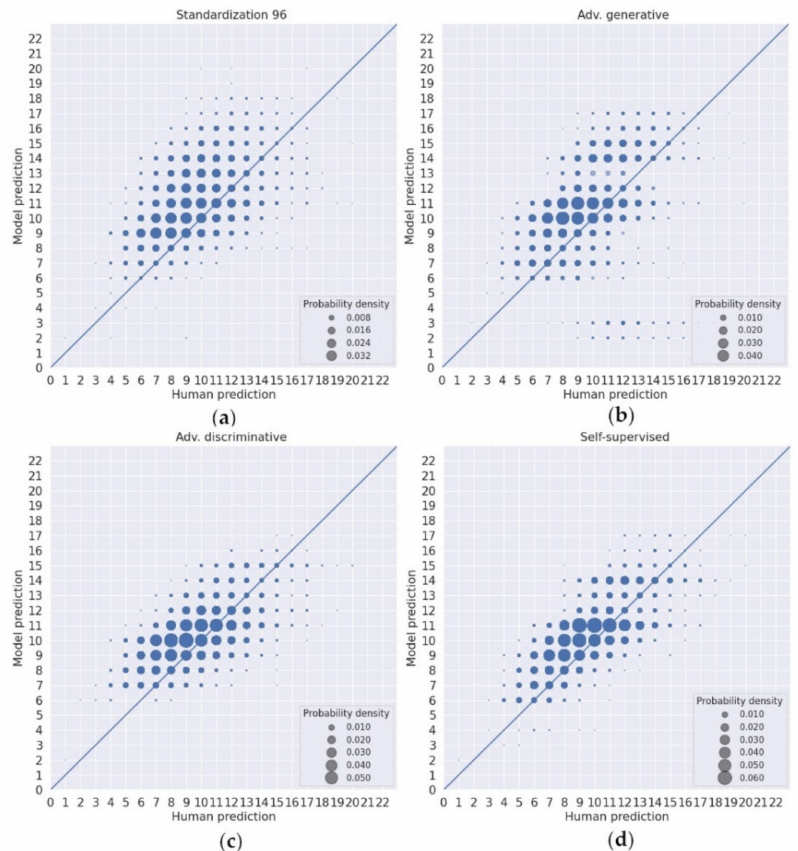
Figure 7. Age predictions of different adaptation models vs. human annotated age obtained from the Icelandic data. For each model, the age predictions correspond to the calculated median from the predicted ages obtained over 5 different trials. The scatters have an area proportional to the probability density of data. ( a ) Age predictions for the simple standardization approach (image resolution 96 × 96 pixels); ( b ) age predictions for the adversarial generative adaptation; ( c ) age predictions for the adversarial discriminative adaptation; ( d ) age predictions for the self-supervised